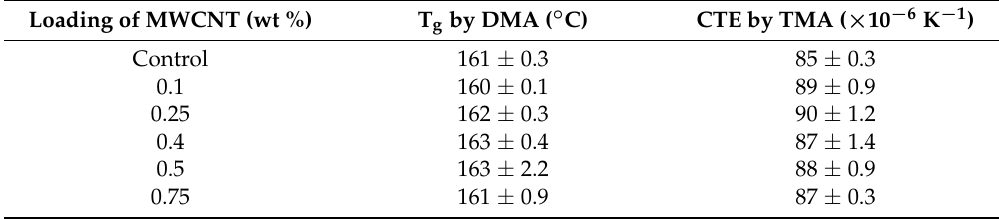
Table 3. Glass transition temperature T g and CTE of the f-MWCNT series relative to the neat epoxy. Loading of MWCNT (wt%)